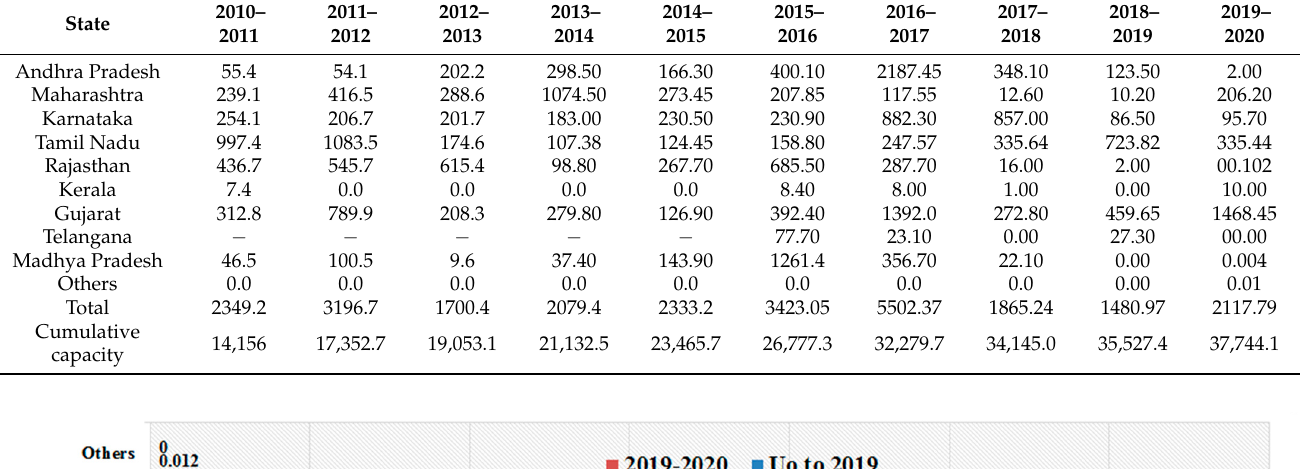
Table 15. Installed wind power capacity (in MW) by year and state, as at 31 March 2019. Source; Indian Wind Energy Association (IWEA) [60] (as at 31 March 2020).